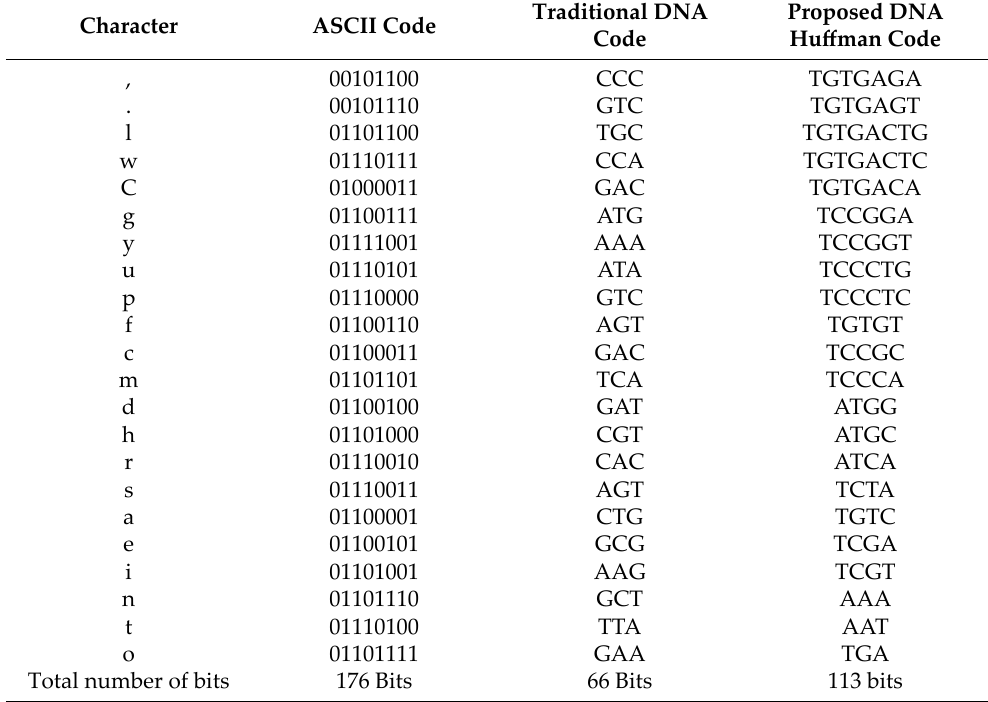
Table 11. Analysis on Numbers of bits required to Encode.